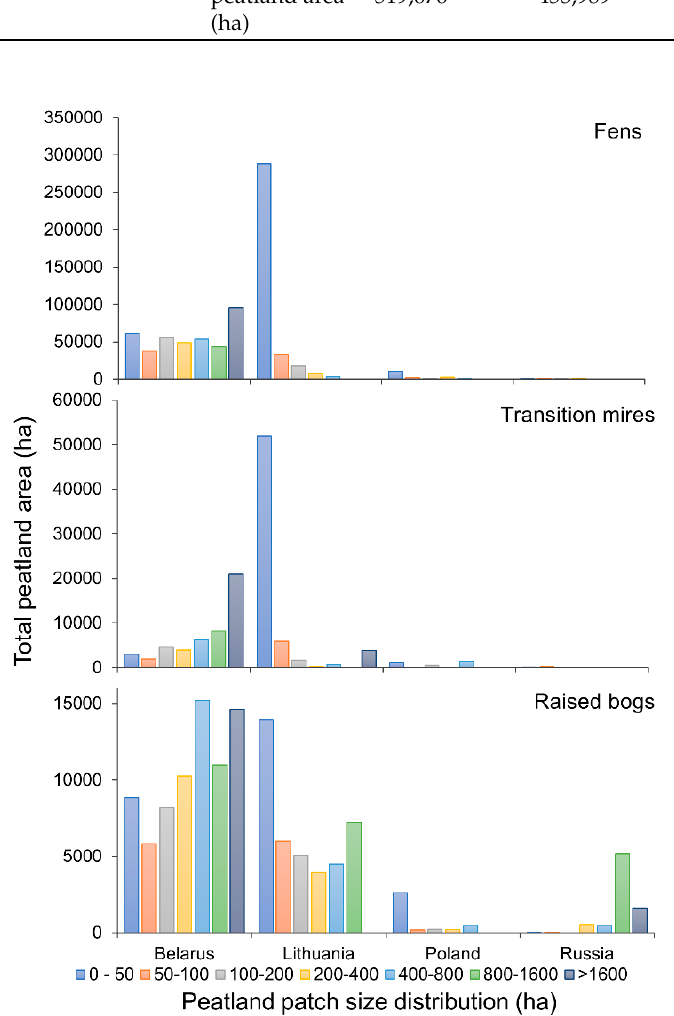
Figure 4. Peatland patch size class distribution by peatland types in the four countries of the Neman River basin. Note the changing scale on the vertical axis.